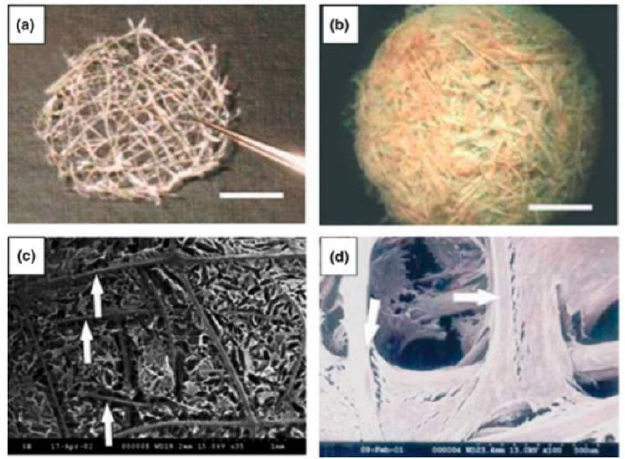
Figure 1. Collagen thread mesh imaged using optical microscopy ( a ); reinforced collagen sponge with collagen mesh ( b ); Collagen sponge reinforced by collagen mesh using SEM micrographs ( c ); and the incorporation of fibroblasts growing within collagen mesh using SEM micrographs ( d ). Reprinted by permission from Springer Nature: Biotechnology and Bioprocess Engineering reference [50]. Copyright